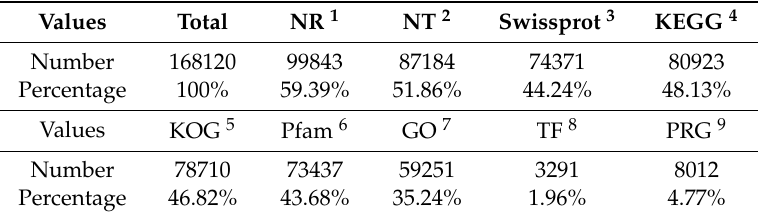
Table 3. Overview of unigenes function annotation.